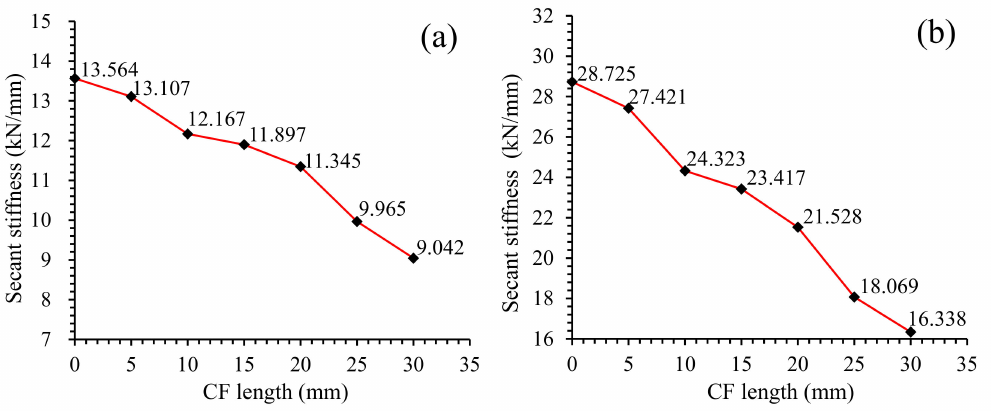
Figure 8. Secant sti ff ness of L-D curve: ( a ) T7; ( b )